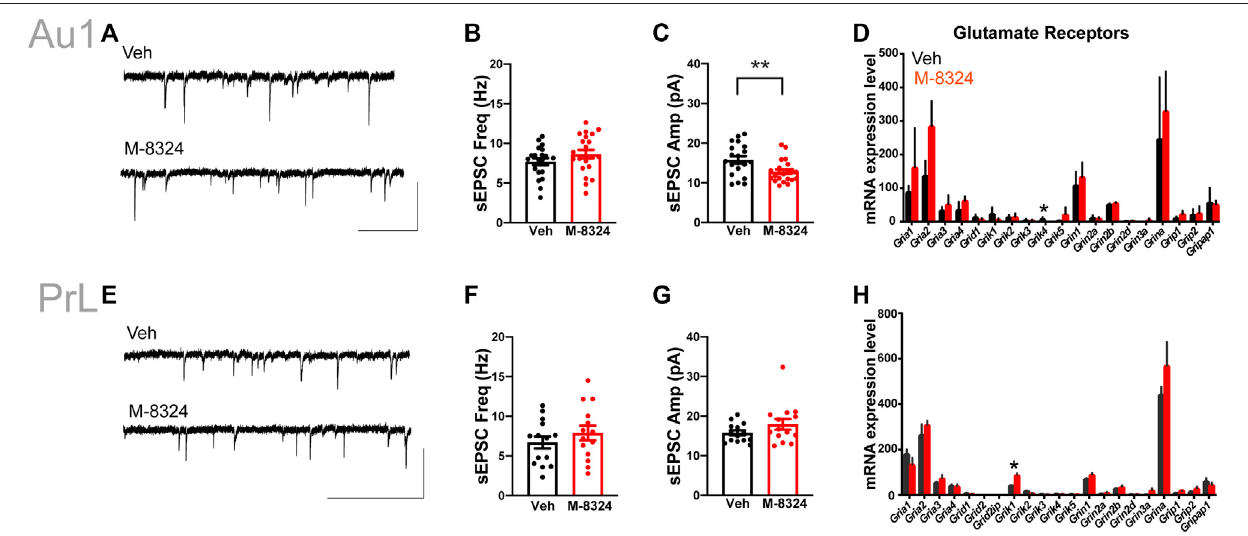
FIGURE 4 | Changes in excitatory synaptic transmission and glutamate receptors in PV-neurons after 7-days M-8324 treatment in Au1 and PrL-PFC. (A) Representative traces of sEPSC from Au1 PV-neurons in Veh and M-8324 groups. Scale bars, 50 pA/500 ms. (B) Frequency of sEPSC was not different between Veh and M-8324 groups in Au1. (C) A signi fi cantly lower amplitude of sEPSC in M-8324 group compared to Veh group in Au1. (E) Representative traces of sEPSC in PV- neuronsinVehandM-8324groupsinPrL-PFC.Scalebars,50 pA/500 ms. (F) FrequencyofsEPSCwasnotdifferentbetweenVehandM-8324groupinPrL-PFC. (G) Amplitude of sEPSC was not different between Veh and M-8324 group in PrL-PFC. (D,H) Expressions of Glutamate receptor subunits in PV-neurons identi fi ed in Au1 (D) and PrL-PFC (H) by RNA-seq. N (cid:2) 20 cells/3 mice for both groups in Au1, N (cid:2) 14 cells/3 mice for both groups in PrL-PFC. * p < 0.05. ** p < 0.01.